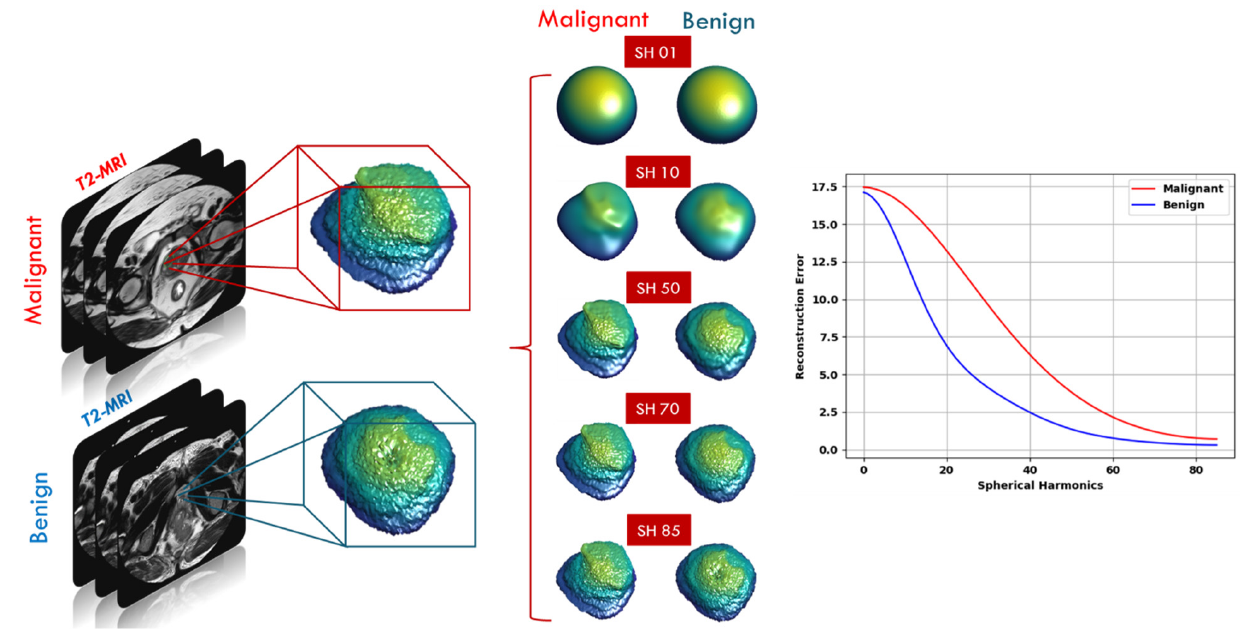
Figure 9. Reconstruction errors differences at different spherical harmonics (SH 01, 10, 50, 70, 85) between a malignant case and a benign case.